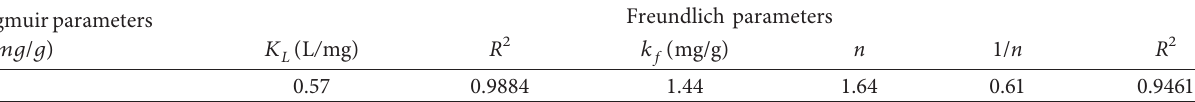
Table 5: The isotherm parameters of Langmuir and Freundlich for Pb (II) adsorption by CISAC.